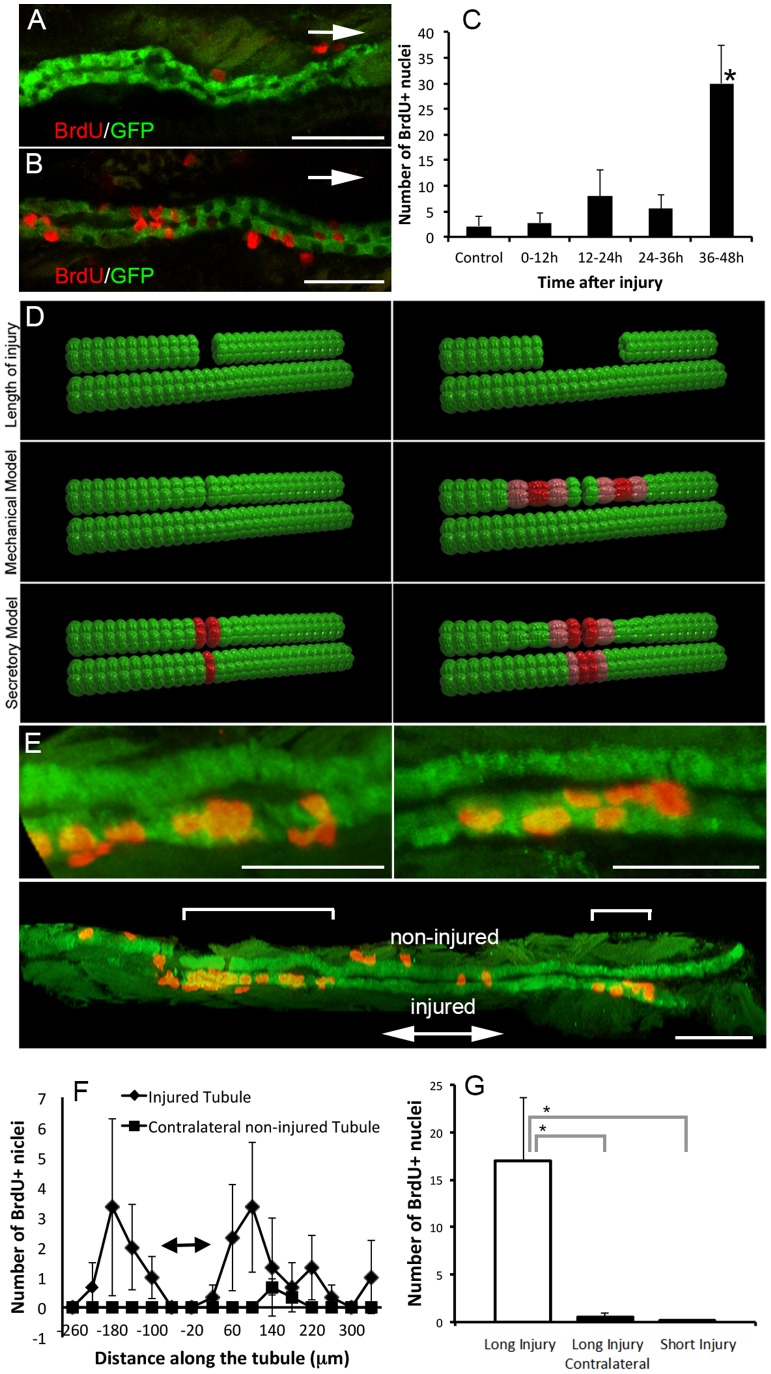
Kidney epithelial proliferation after acute injury.(A,B) Two examples of BrdU staining after segmental ablation early (0–12 hpi, A) and late (36–48 hpi, B) in ET11-9 GFP transgenic fish. Arrows indicate the direction of injury. Confocal slice thickness is 1.5 µm in (A), and 1.6 µm in (B). (C) Number of BrdU+ cells at various intervals after segmental laser ablation (0–12 hpi, n = 4, 12–24 hpi, n = 3, 24–36 hpi, n = 4, 36–48 hpi, n = 4) and compared to non-injured control condition (n = 8). There was no significant increase in cell proliferation early in the repair process (up to 36 hpi) but a pronounced increase in cell proliferation first detectable between 36 and 48 hpi, compared to control condition (p<0.05, C). (D) Two possible mechanisms that could trigger cell proliferation (mechanical stretch due to cell migration vs. a secretory factor) lead to different predictions about the distribution of cell proliferation after segmental ablation. Red color indicates the predicted distribution of cell proliferation after short (left panel) vs. long (right panel) tubule segment ablation. Upper row: initial injury; middle row: stretch response scenario (mechanical model). Lower row: secretory factor scenario. (E) Long segmental ablation resulted in two distinct bands of BrdU incorporation both upstream (left and lower sub-panels) and downstream (right and lower sub-panels, each sub-panel represents a confocal projection image). Brackets in the lower sub-panel indicate bands of proliferation upstream and downstream of the injury. The right and left upper sub-panels show a higher magnification of the areas of proliferation marked by brackets in the lower sub-panel. Other BrdU+ nuclei are outside of the kidney. (F) Comparison of BrdU incorporation in the injured (rhombi) vs. contralateral non-injured tubule (squares). This pattern of BrdU incorporation is most consistent with the mechanical model of the cell proliferation trigger. Double-arrow bar indicates the approximate site of injury. (G) Total number of BrdU+ nuclei after long (80–100 µm) vs. short (20 µm) segmental ablation (24–48 hpi). Long segmental ablation resulted in significantly increased number of BrdU+ cells compared to a contralateral non-injured side (as well as kidney epithelium after short injury or in a non-injured control). Long injury vs. contralateral non-injured tubule: p = 0.039, long injury vs. short injury: p = 0.048, n = 3 per each condition. Scale bars in (A,B and E upper sub-panels) = 30 µm, and 60 µm in (E, lower sub-panel).